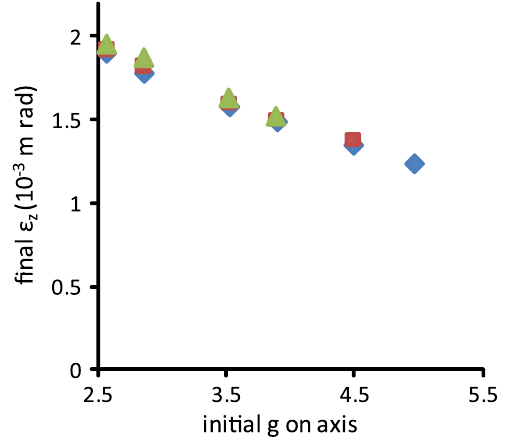
current.FIG. 10. Final z emittance at z ¼ 60 m ( (cid:1) 10 (cid:2) 3 ) vs initial geometric factor on axis with various pipe radius.